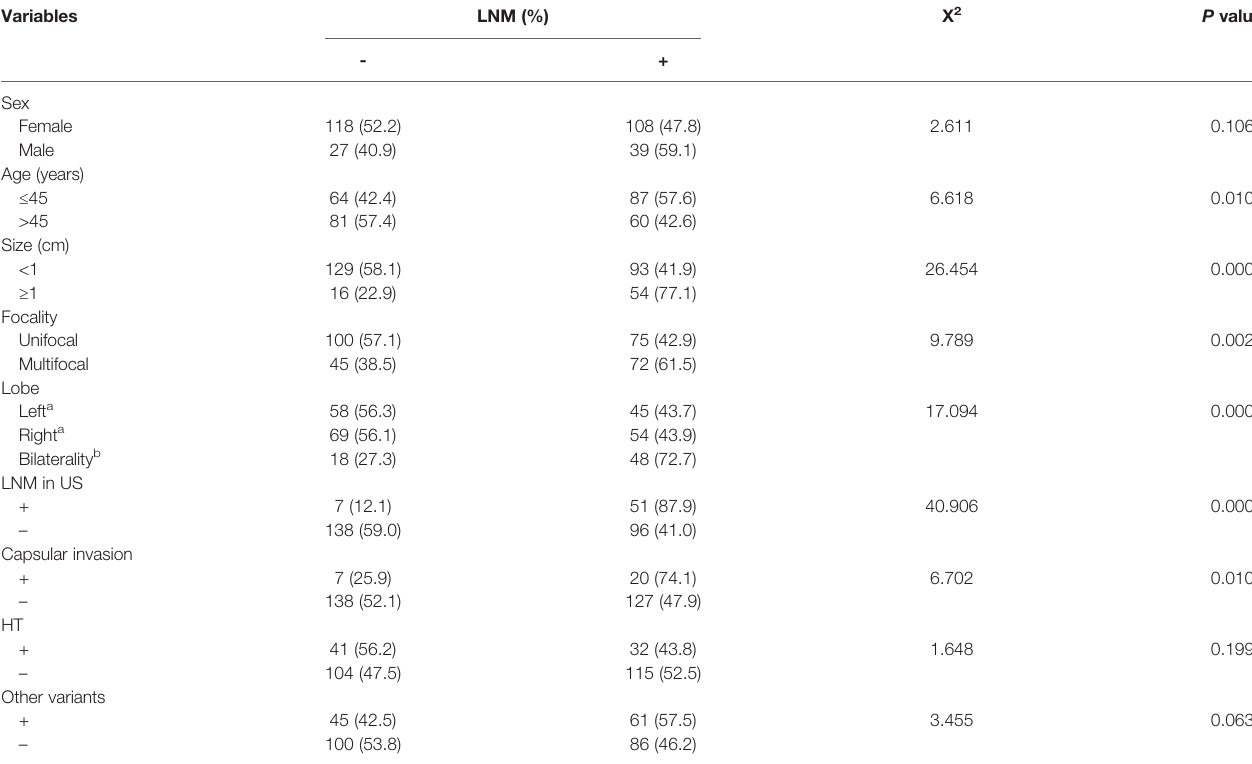
TABLE 1 | Association between LNM and clinical, molecular characteristics of PTCs with the BRAF V600E mutation.